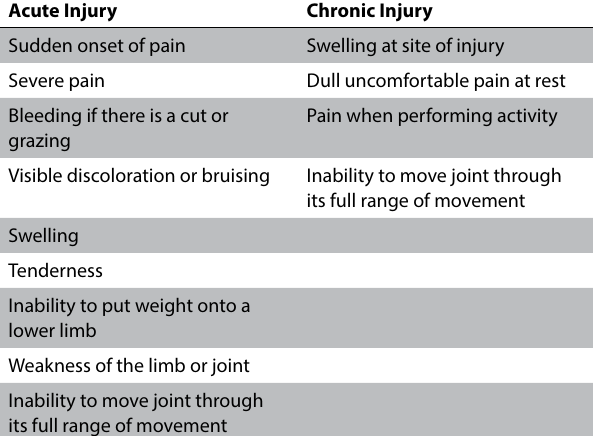
Table 1: Signs and symptoms of acute and chronic sport injuries 4